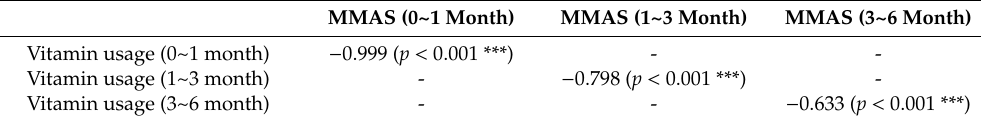
Table 6. Correlation between MMAS scale and vitamin usage